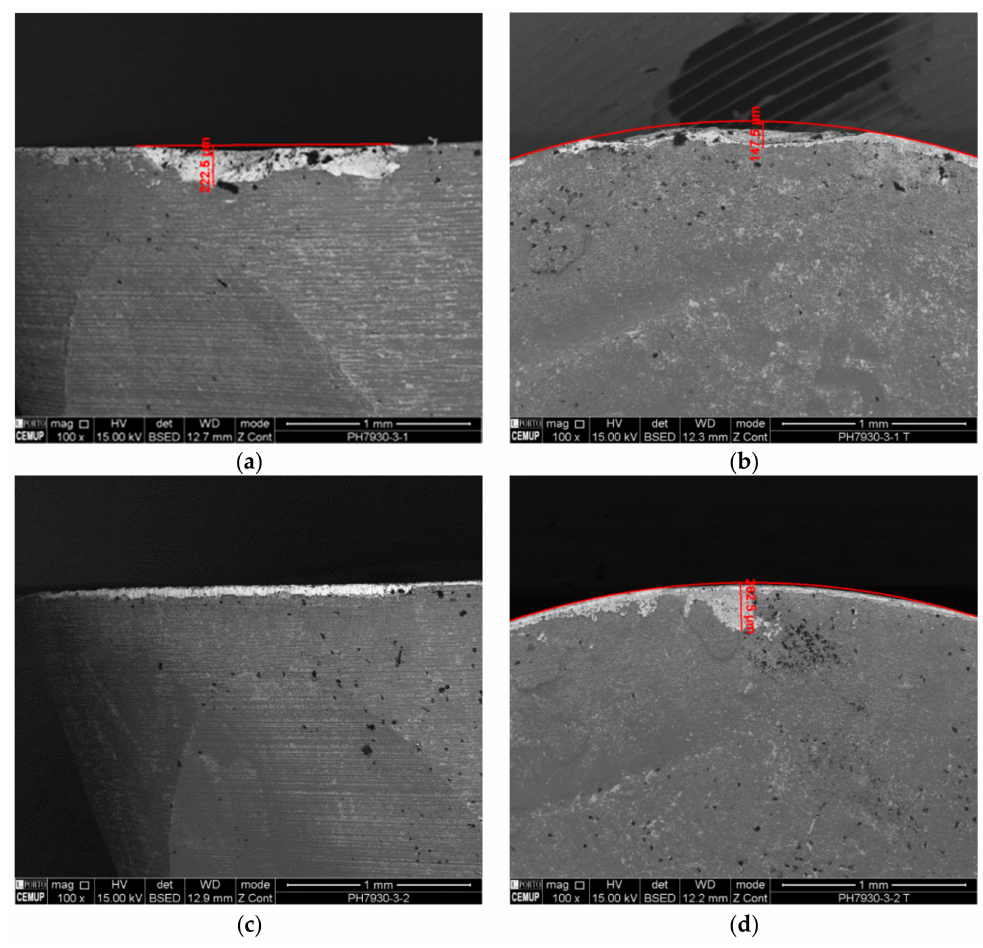
Figure 5. ( a ) and ( c ) flank wear (VB) of PVD PH7930-S1 and PH7930-S2 cutting inserts, respectively; ( b ) and ( d ) rake face / land wear (KB) of PVD PH7930-S1 and PH7930-S2 cutting inserts, respectively.